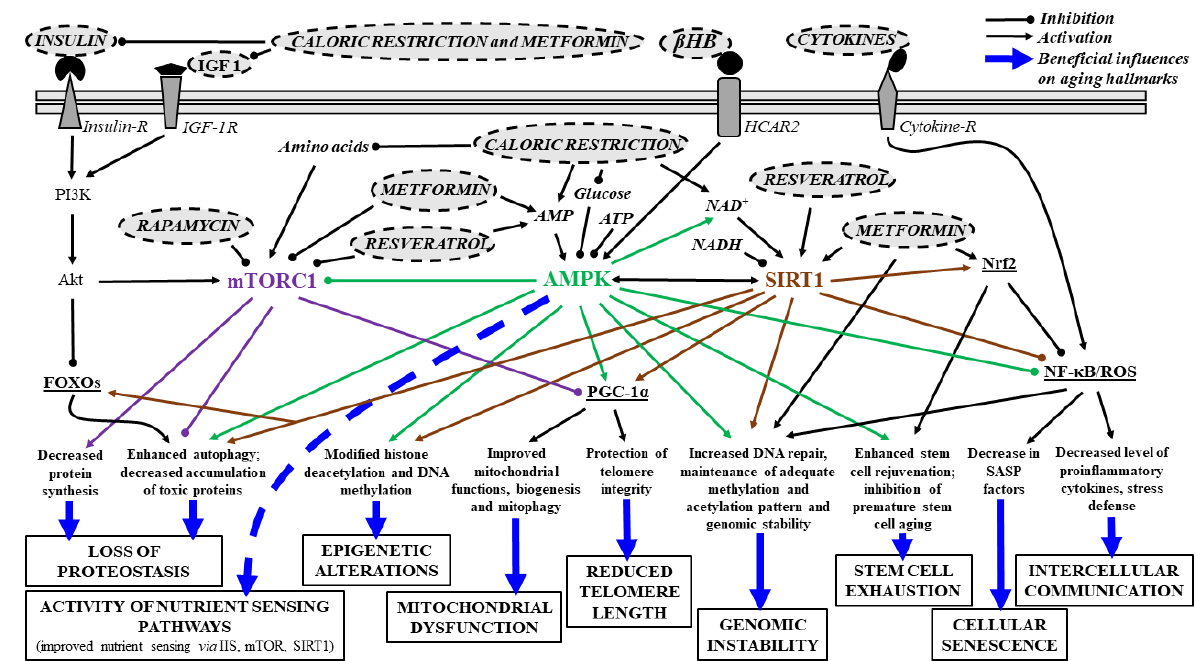
Figure 1. Main downstream signaling pathways and some effects, by which different senomorphic drugs (e.g., metformin), interventions (e.g., caloric restriction) and, theoretically, exogenous ketogenic supplements-evoked ketosis (βHB) can improve age-dependent impaired processes (aging hallmarks). Abbreviations: Akt, Akt kinase/protein kinase B; AMPK, AMP activated serine-threonine protein kinase; ATP, adenosine triphosphate; βHB, beta-hydroxybutyrate; FOXOs, Forkhead box Os; HCAR2, hydroxycarboxylic acid receptor 2; IGF 1, insulin-like growth factor 1; mTORC1, mechanistic target of rapamycin C1; NAD + , nicotinamide adenine dinucleotide; NADH, nicotinamide adenine dinucleotide (NAD) + hydrogen (H); NF-κB, nuclear factor kappa-light-chain-enhancer of activated B cells; Nrf2, nuclear factor erythroid 2-related factor 2; PGC-1α, peroxisome proliferator-activated receptor gamma (PPARγ) coactivator-1α; PI3K, phosphatidyl inositol-3-kinase; ROS, reactive oxygen species; SASP, senescence associated secretory phenotype; SIRT1, Sirtuin 1.